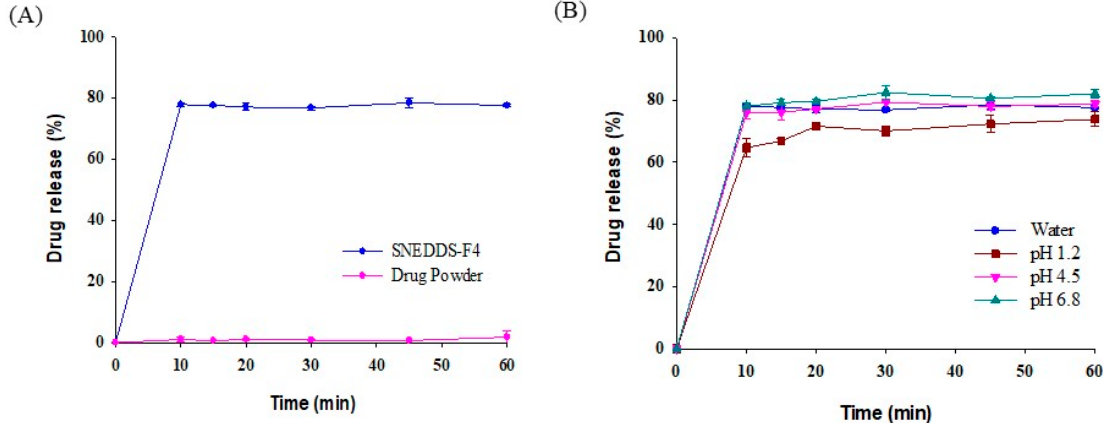
11 of 15 Figure 5. TEM image of SNEDDS-F4. 3.5. In Vitro Drug Release Studies The drug release profile of SNEDDS-F4 was evaluated in comparison with that of the drug powder. As shown in Figure 6A, SNEDDS-F4 significantly enhanced the rate and extent of drug release in water, achieving approximately 80% drug release within 10 min, while drug dissolution from the drug powder was minimal (<2%). This could be because